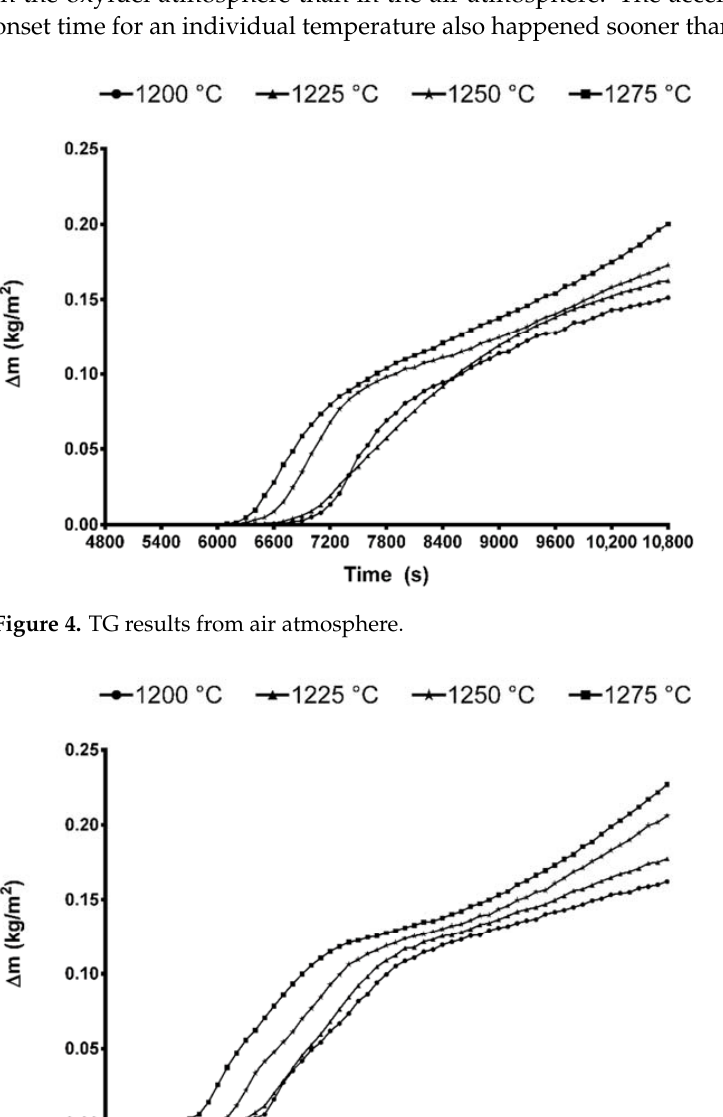
Figure 4. TG results from air atmosphere.